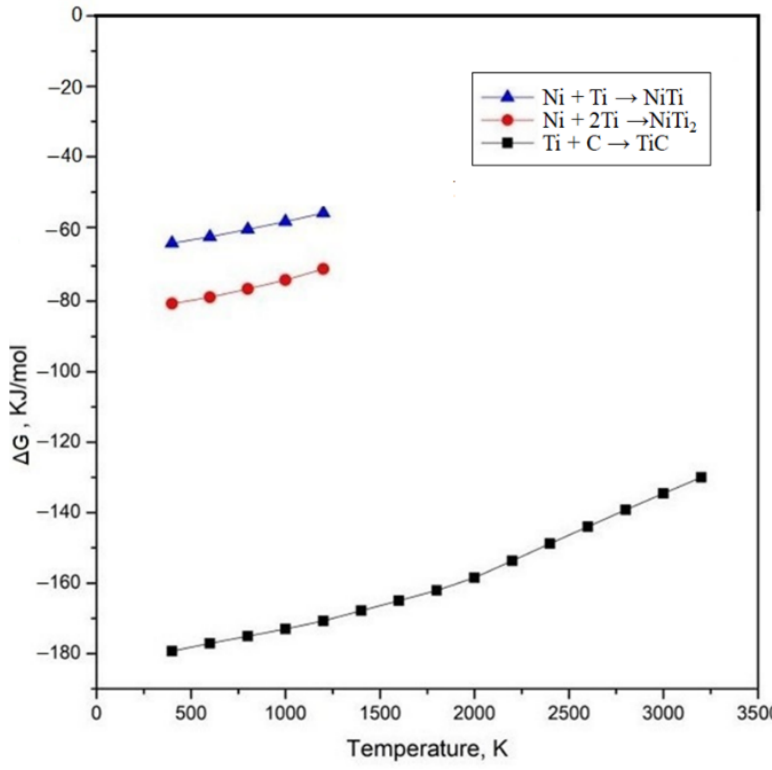
Figure 4. The change of Gibbs free energy of chemical reaction.